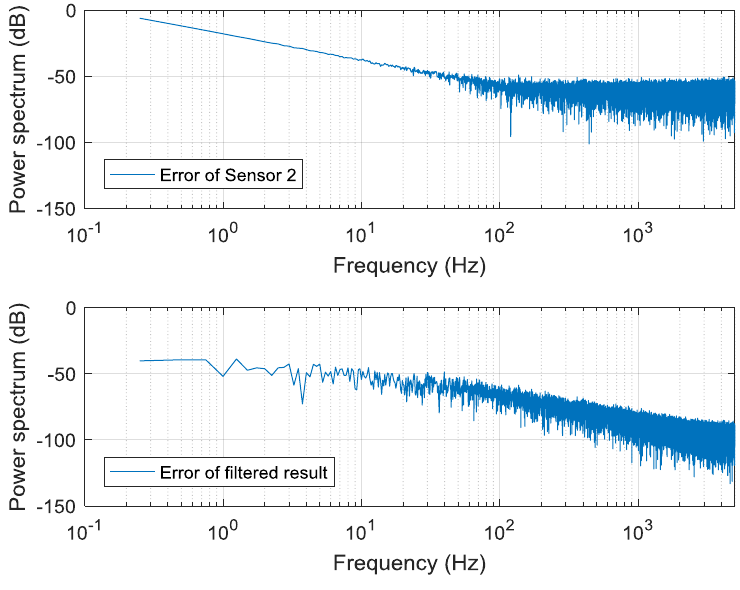
Figure 8. Power spectra of the errors.